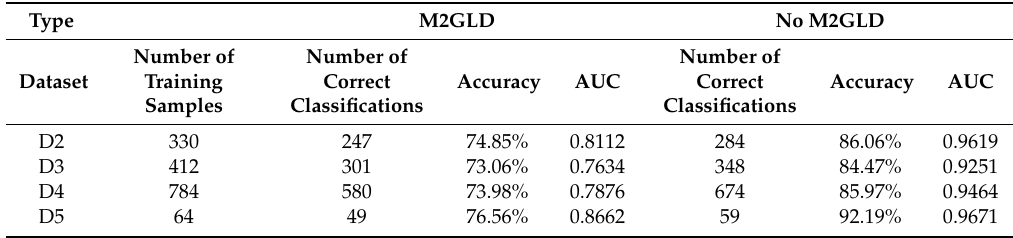
Table 9. The results of the surface crack classification in UAV images using M2GLD and no M2GLD.